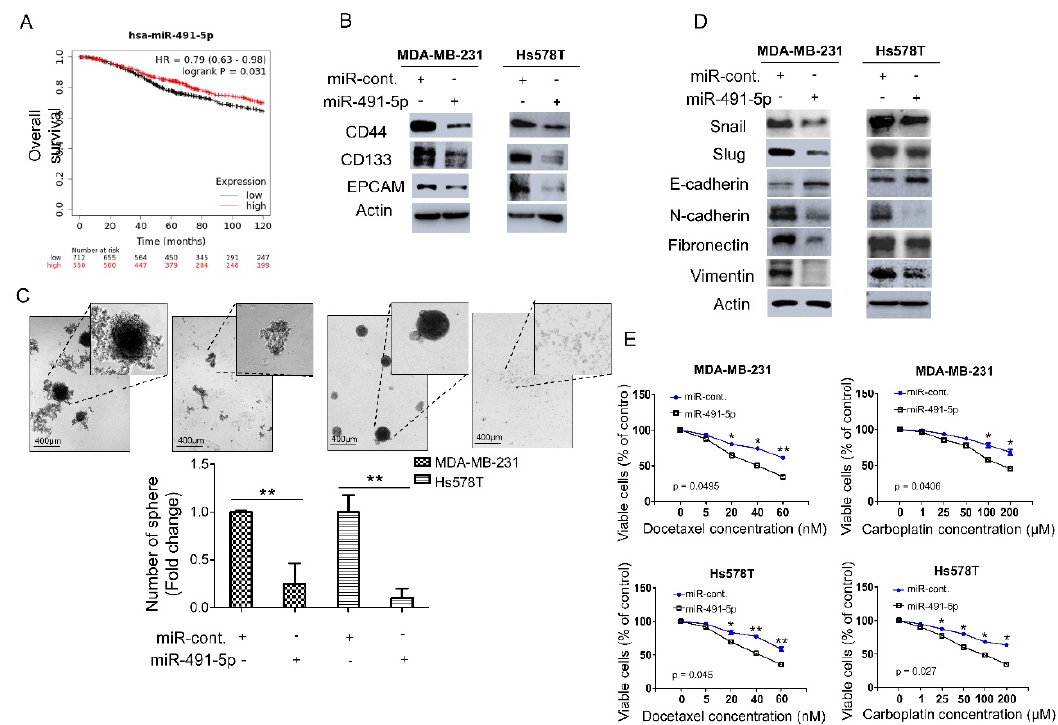
Figure 1. miR-491-5p correlates with better overall survival and inhibits cancer stemness, EMT and drug resistance in TNBC. ( A ) Analysis of Kaplan–Meier plotter database for miR-491-5p expression in association with the overall survival of 1262 breast cancer patients. ( B ) Western blot showing protein expression levels of breast cancer stem cell markers in MDA-MB-231 and Hs578T cells transfected with miR-491-5p or control. Actin served as the internal control. ( C ) Observations of sphere formation under stem cell selective conditions after 8 days of culturing MDA-MB-231 and Hs578T cells transfected with miR-491-5p or control. Representative images are shown. Histograms represent means ± s.e. from three independent experiments (* p < 0.05, ** p < 0.01). ( D ) Western blot analysis of protein expression levels of EMT markers in MDA-MB-231 and Hs578T cells transfected with miR-491-5p or control. Actin served as the internal control. ( E ) MTS assay showing the dose-dependent growth inhibition of MDA-MB-231 and Hs578T cells transfected with miR-491-5p or control upon continuous docetaxel or carboplatin exposure at indicated concentrations for 48 h. Each dosage point represents means ± s.e. from three independent experiments (* p < 0.05, ** p < 0.01). All experiments were performed in triplicates and done at least